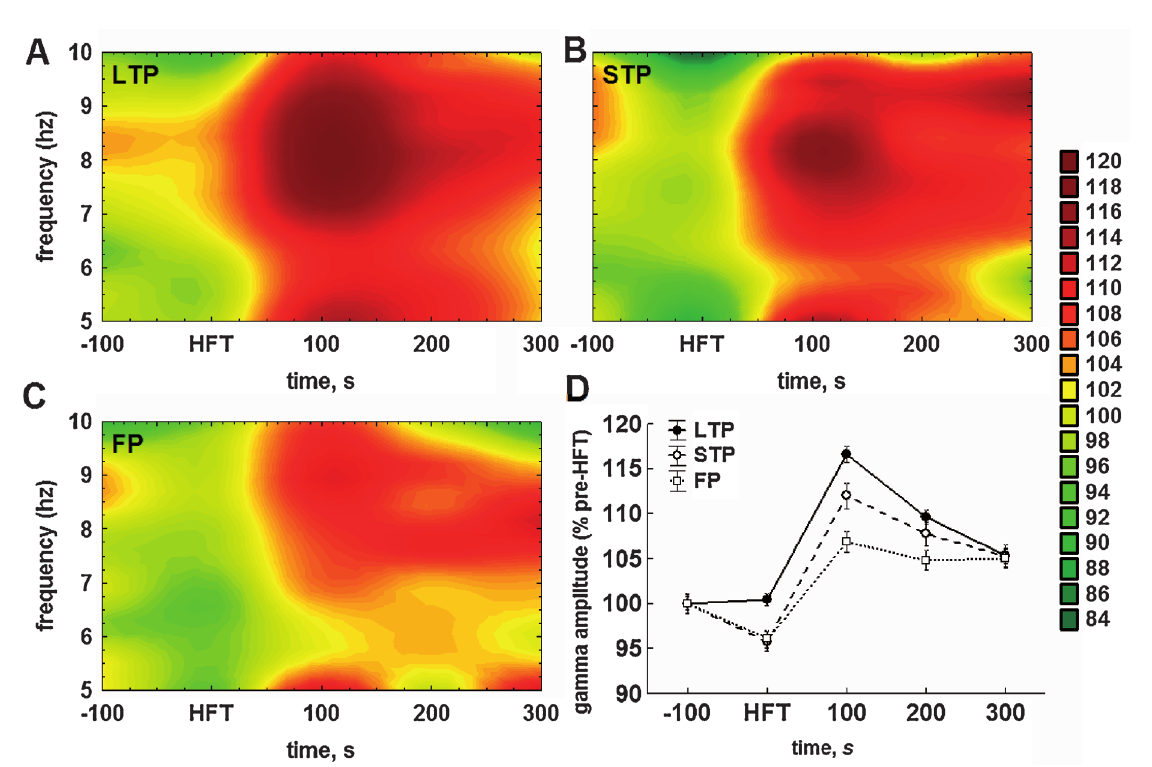
Figure 5. Application of HFT to the medial perforant path increases the mean relative amplitude of gamma oscillations per individual theta cycle in the DG of freely moving animals. ( A–C ) Colour surface plots represent the mean amplitude of gamma oscillations per one theta cycle plotted against frequency of the respective theta cycle (Y-axis) and time to HFT (X-axis) (distance weighted least squares fitting). Colour scale represents percents to the mean pre-HFT value. ( D ) Whisker plot represents mean (cid:3) SEM for LTP (filled circles, solid line), STP (open circles, dashed line) and FP (open squares, dotted line)